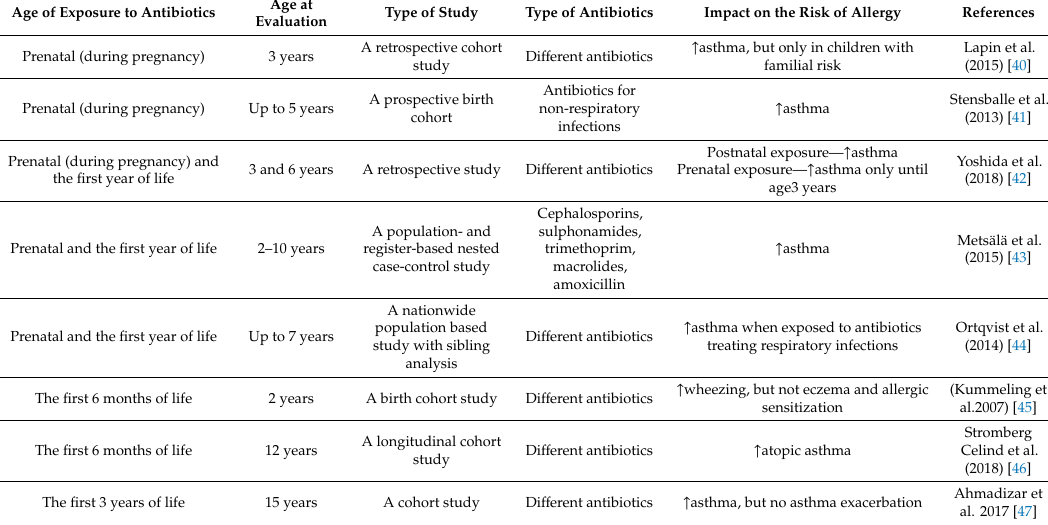
Table 2. Summary of studies demonstrating the impact of antibiotic exposure in the pre-natal period and early post-natal life on the risk of wheeze and